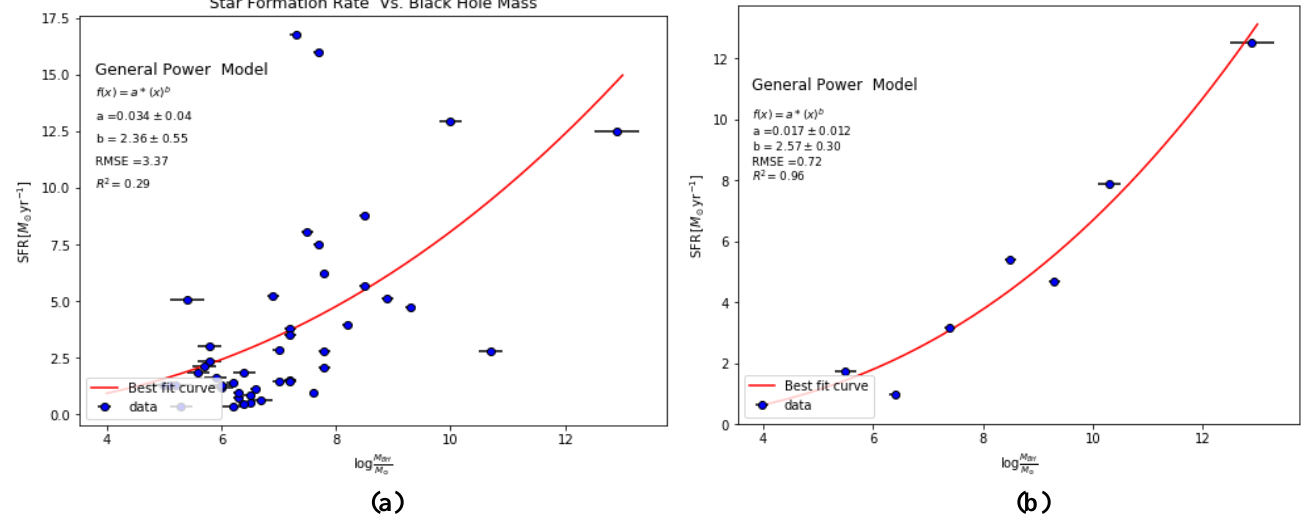
Fig.7: The correlation between the SMBH & SFR for seyfert1 galaxies using power regression, where (a) for all samples, (b) median data.